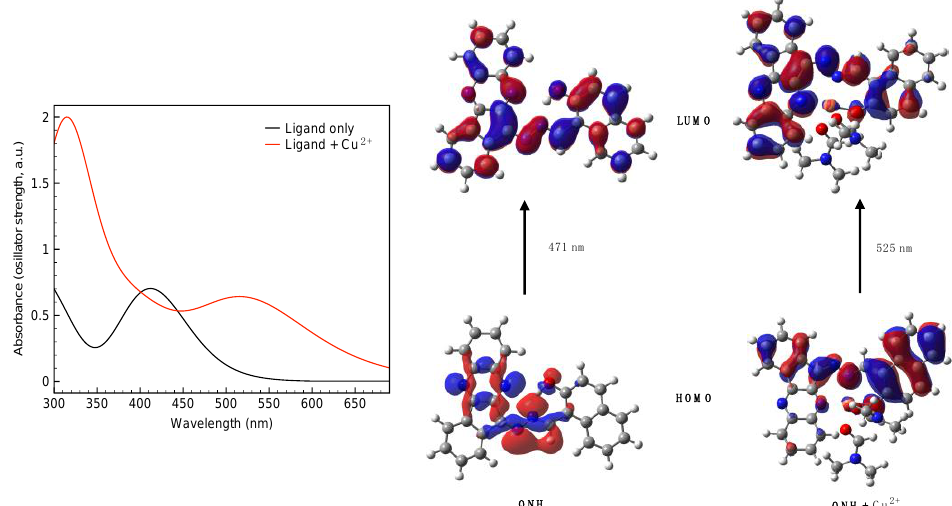
Figure 3. The left panel shows the computed absorption spectra of QNH and QNH in the presence of Cu 2+ , plotted with blue and black lines, respectively. The right panel shows computed frontier molec- ular orbitals (HOMO and LUMO) for QNH and QNH − Cu 2+ model systems. Values in parenthesis are the theoretical absorption wavelengths in nm. Surfaces are generated with an isovalue of 0.02.